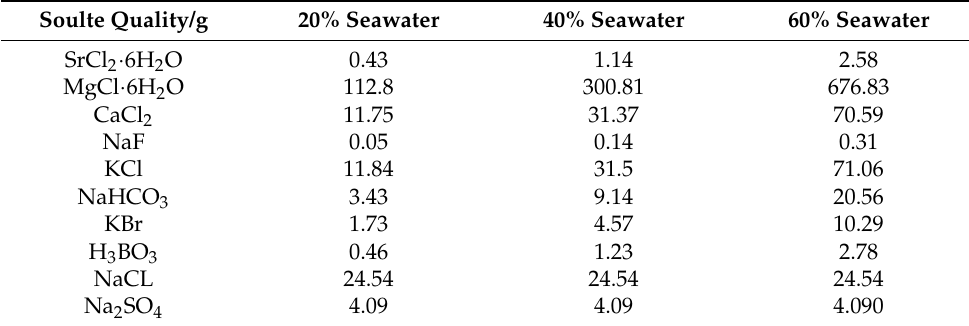
Table 1. Solute mass in simulated seawater at different